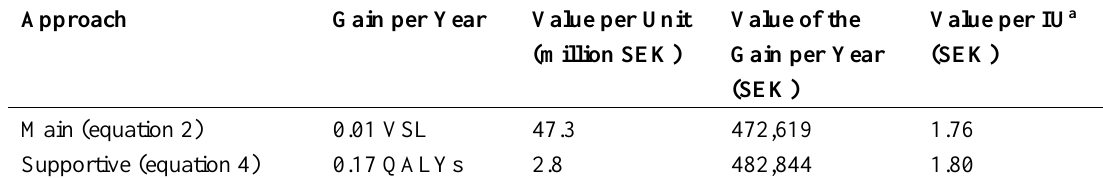
Value of the Value per IU a (million SEK) Gain per Year (SEK) (SEK)